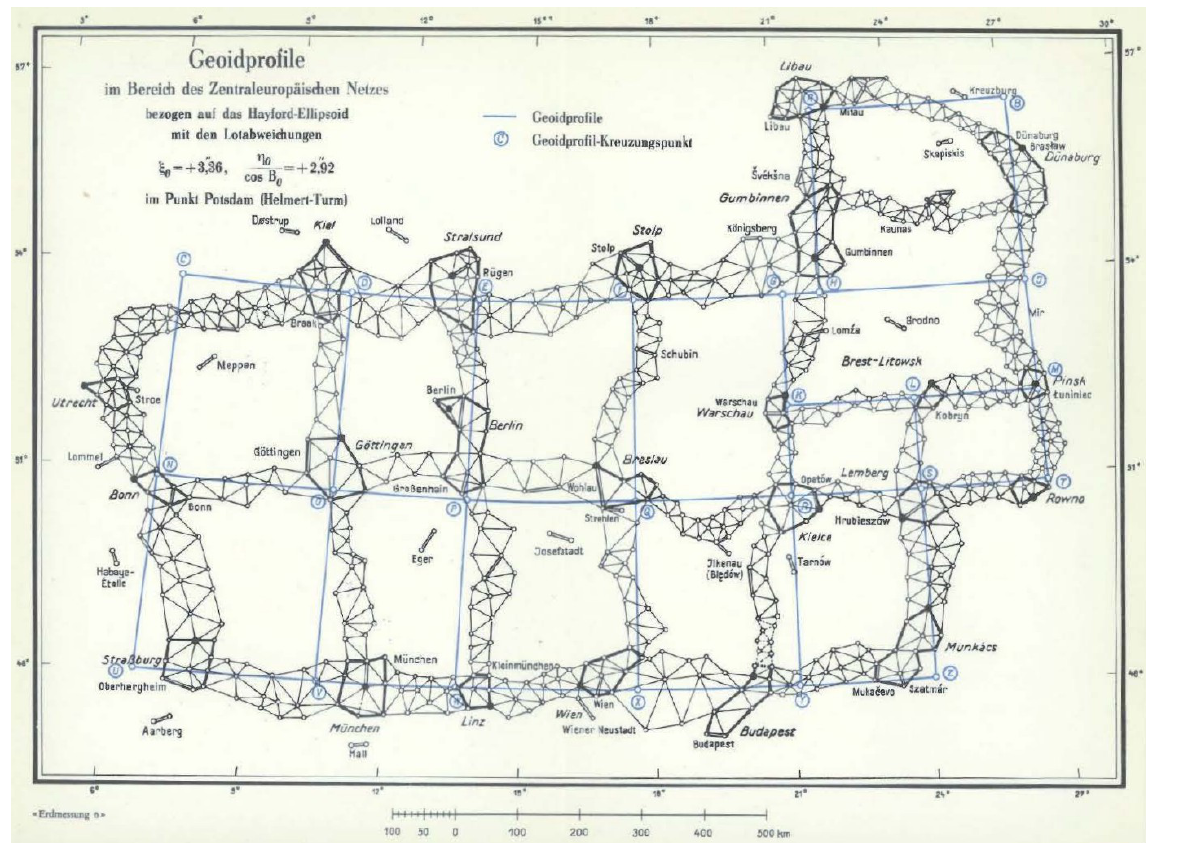
Figure 7. Configuration of the Central European Network, geoid profiles (Wolf,